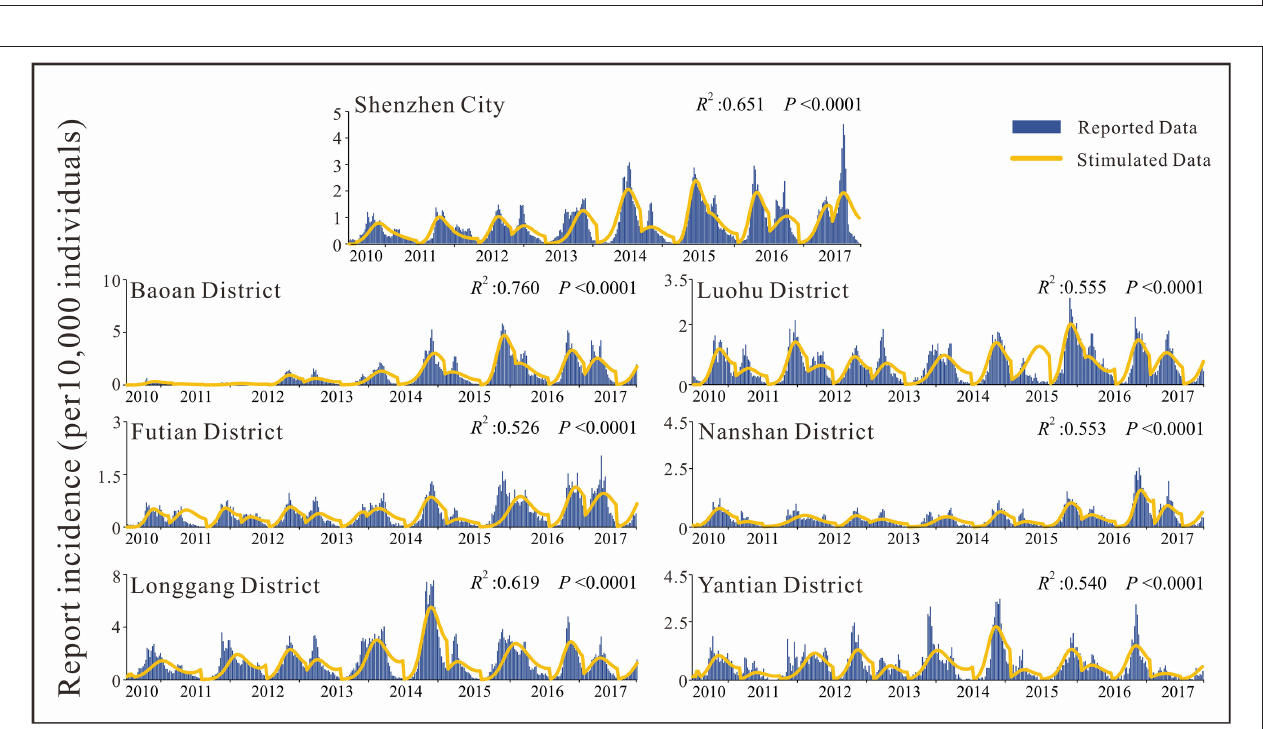
FIGURE 4 | Fitting results for HMFD incidence rates in Shenzhen city and its districts.